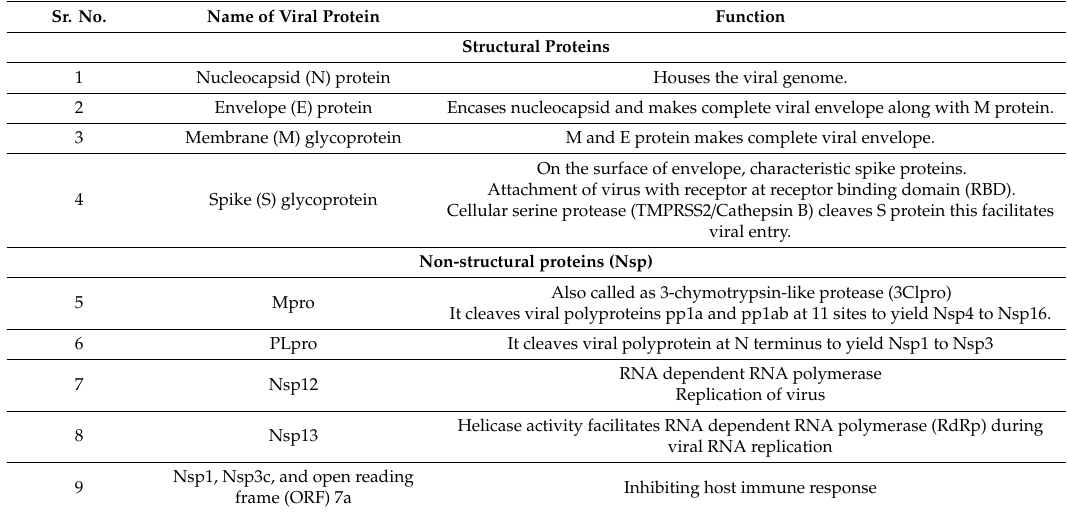
Table 1. Overview of the name and functions of SARS-CoV-2 proteins. The four structural proteins and five of the most important Nsp are provided. Sr.